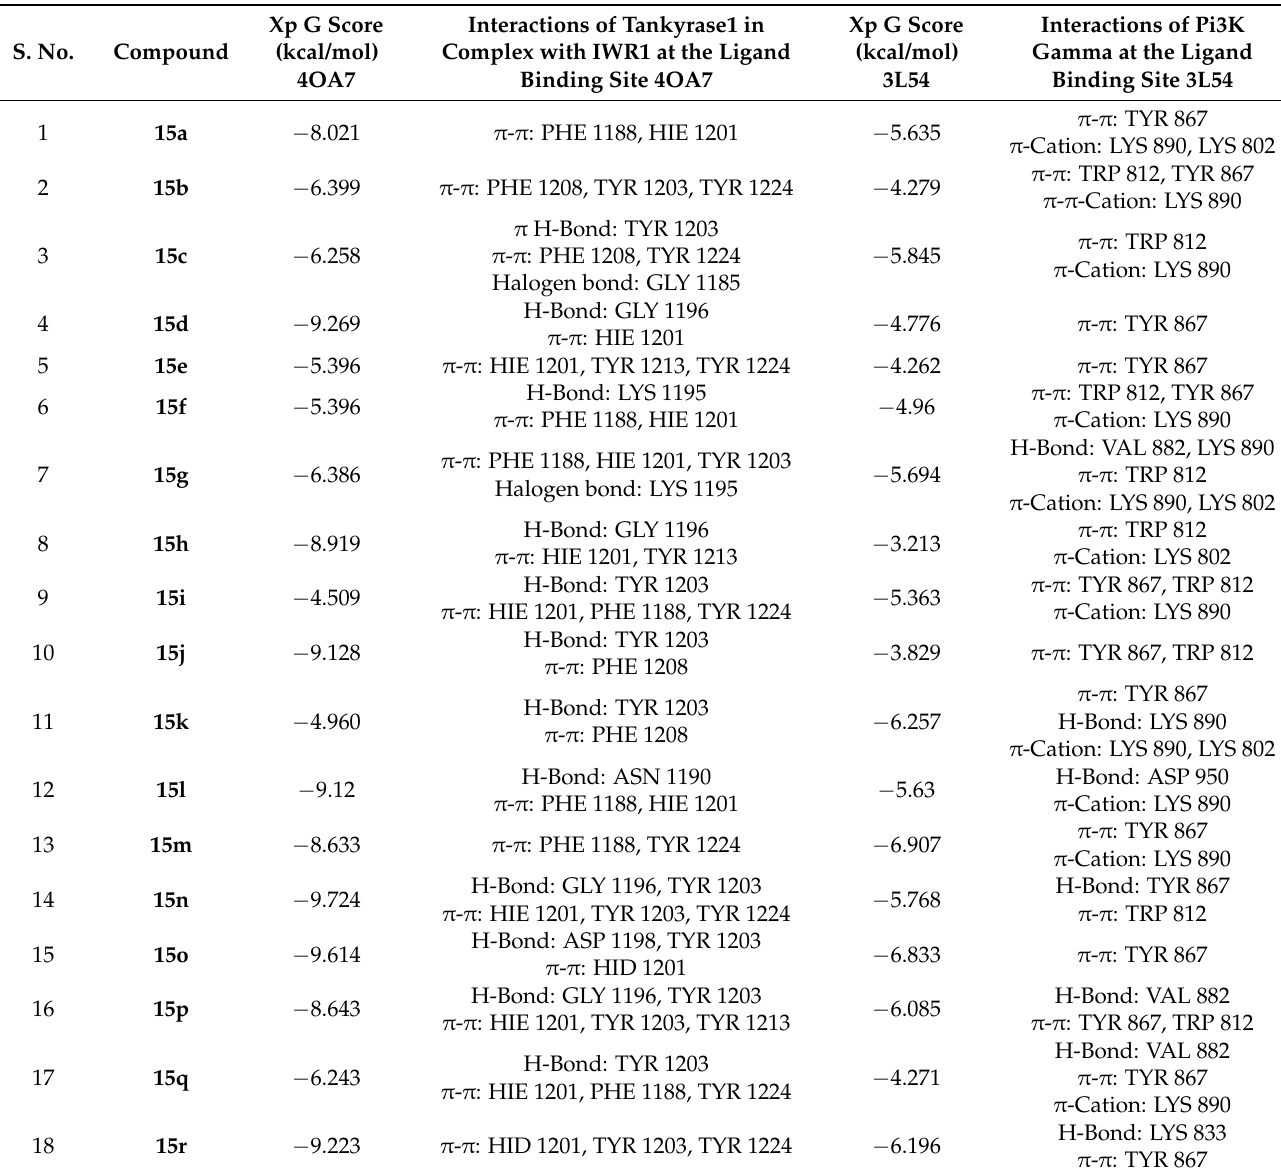
Table 2. Docking scores of all synthesised compounds ( 15a–r ) in the catalytic binding pocket of tankyrase and PI3K receptor in colorectal cancer (PDB IDs: 4OA7 and